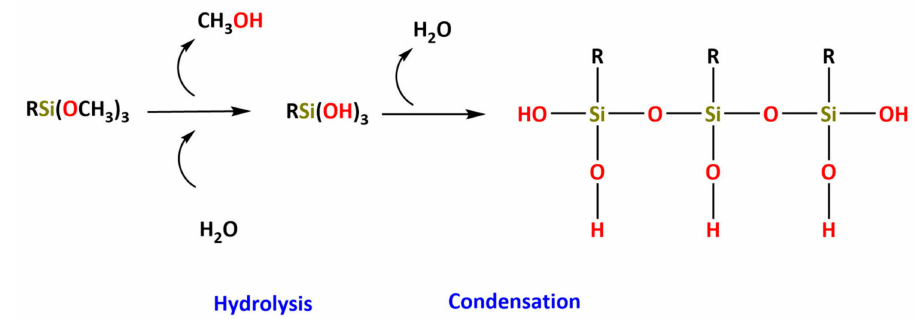
Figure 4. Generic two step reactions involved in the preparation of OIH materials through the sol–gel method using as the network-forming element the Si. R is typically an alkyl group. Adapted from